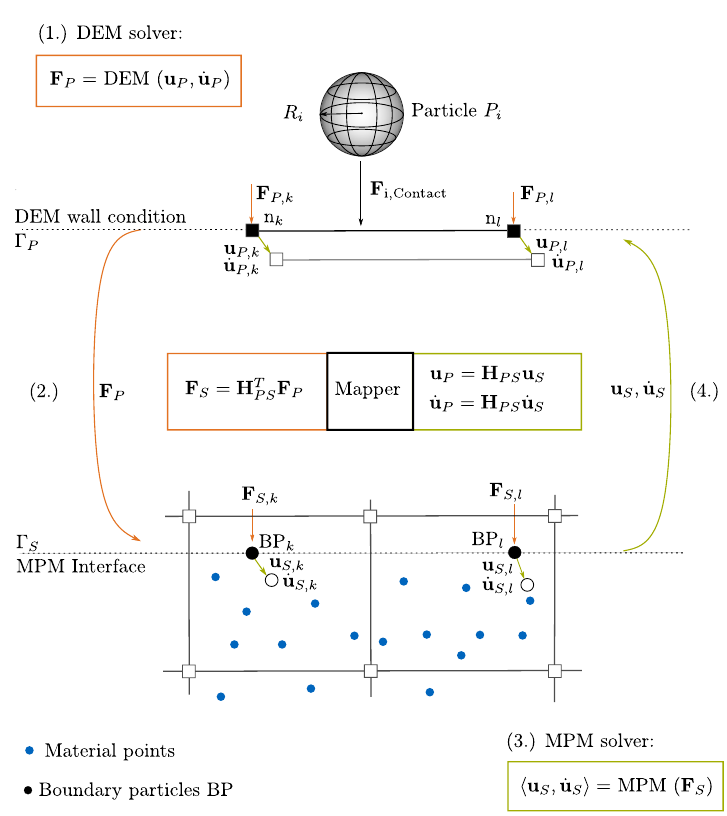
Fig. 4 Partitioned MPM-DEM coupling scheme: In each time step, DEM is solved first (1). The resulting forces are mapped to MPM as external forces (2). Then MPM is solved leading to a kinematic update of the MPM interface (3), which is mapped back to DEM interface (4). Due to weak coupling, the steps are repeated for the next time